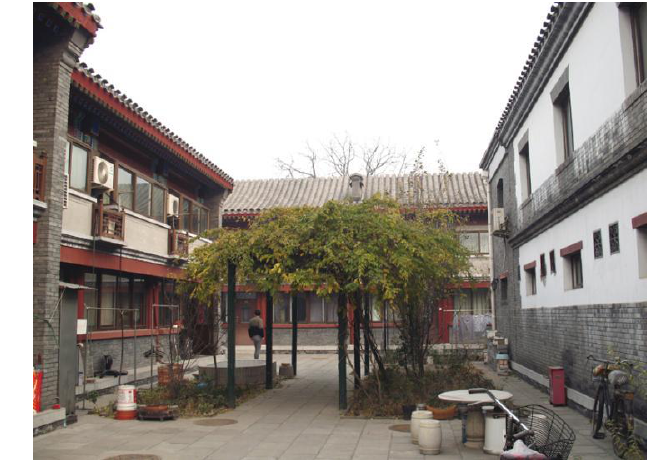
Figure 5. A new courtyard at Beijing Nanchizi Chinese-style new courtyard housing estate. Photo: Donia Zhang